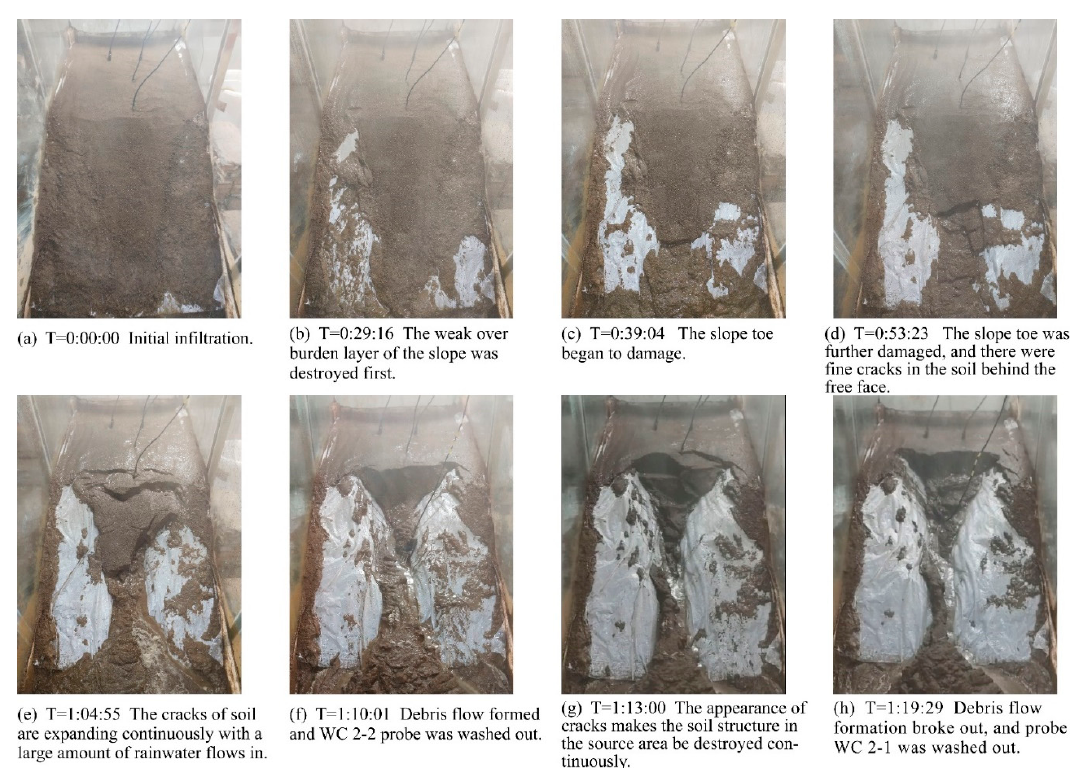
Figure 10. Damage characteristics of ZJCG condition under extraordinary rainstorm (77.65 mm/h).